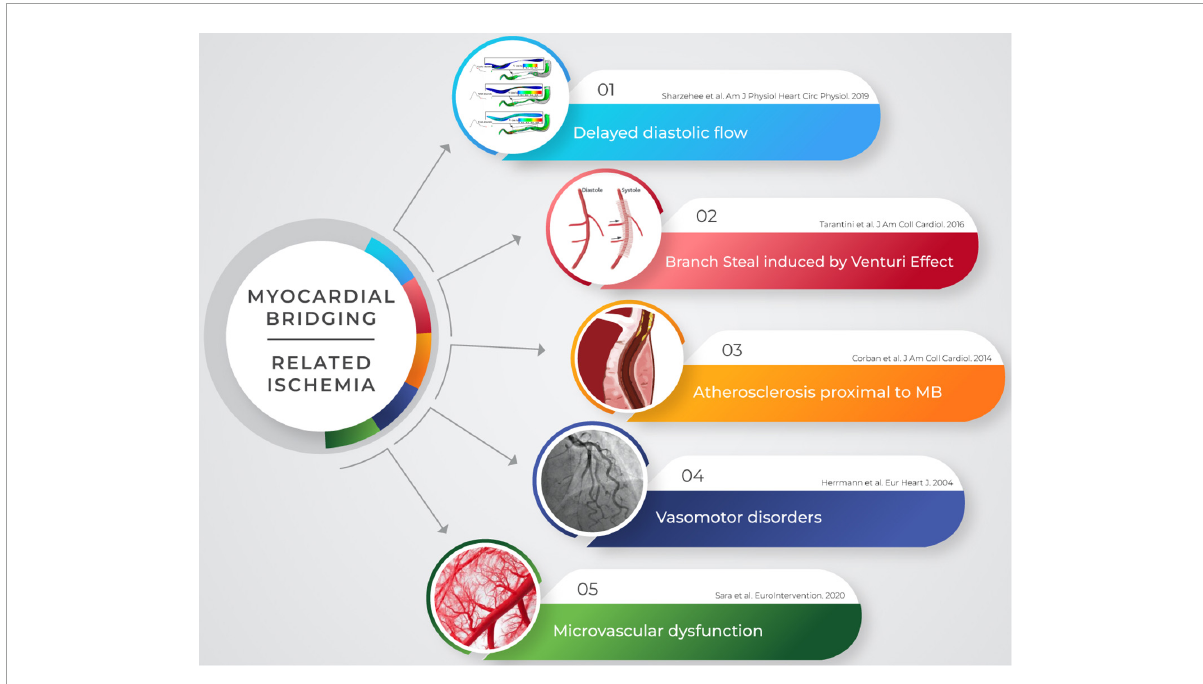
FIGURE1 Myocardial ischemia is not purely related to vessel systolic compression in patients with MB. Several mechanisms may account for the occurrence of symptoms and may be detected though invasive and non-invasive modalities. MB, myocardial